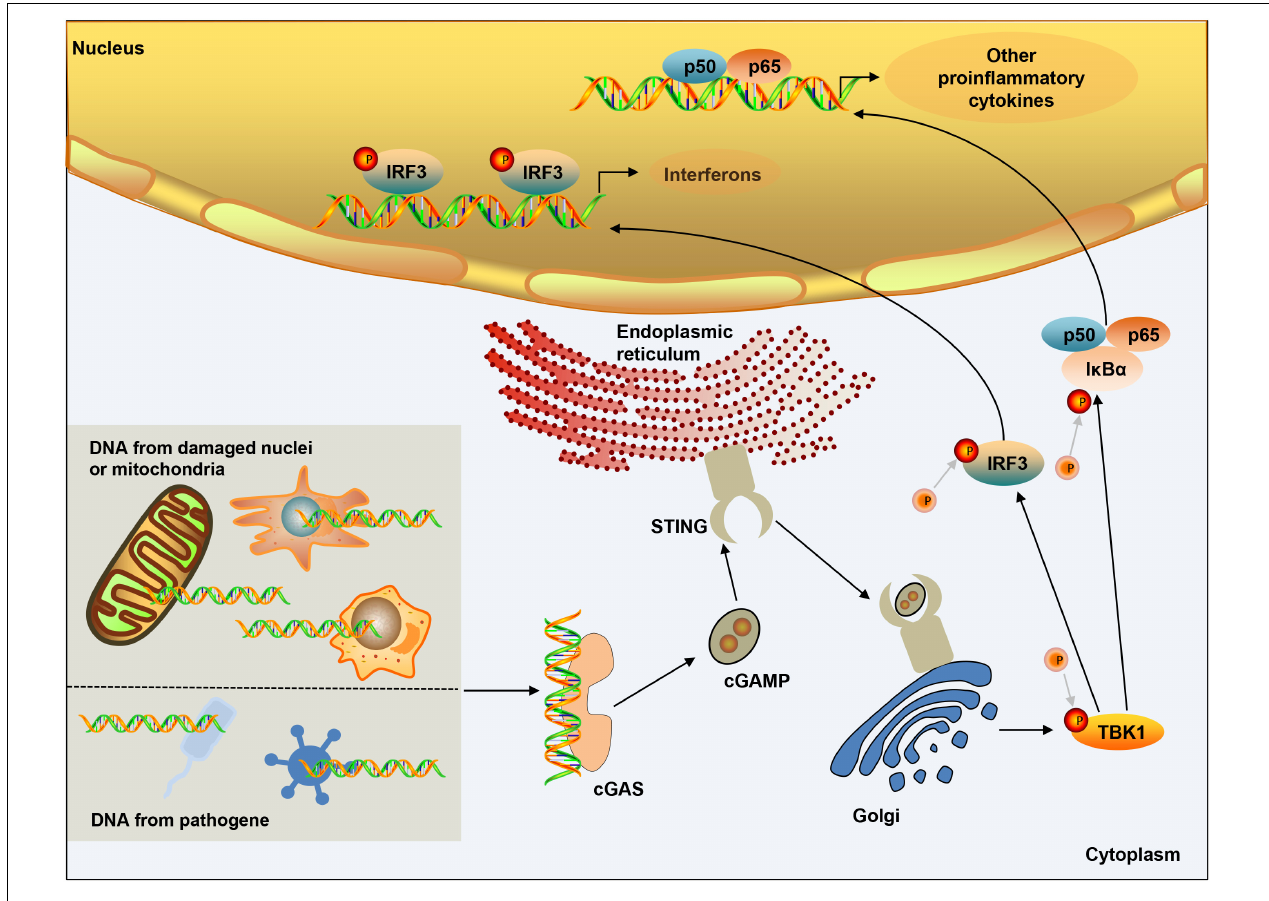
FIGURE 1 | cGAS-STING signaling activation. DNA from microbial pathogens, damaged nuclei, or mitochondria binds and activates cGAS, and catalyzes the synthesis of cGAMP. cGAMP functions as a second messenger and binds to the ER-membrane adaptor STING and induces a conformational change that presumably results in the activation of STING. STING traffics from the ER to an ER-Golgi intermediate compartment and the Golgi apparatus, and then activates TBK1. TBK1 phosphorylates the transcription factor IRF3. STING also activates NF-kB, which enters the nucleus, where it functions together with IRF3 to induce the expression of type I IFNs and many other genes that mediate immune and inflammatory